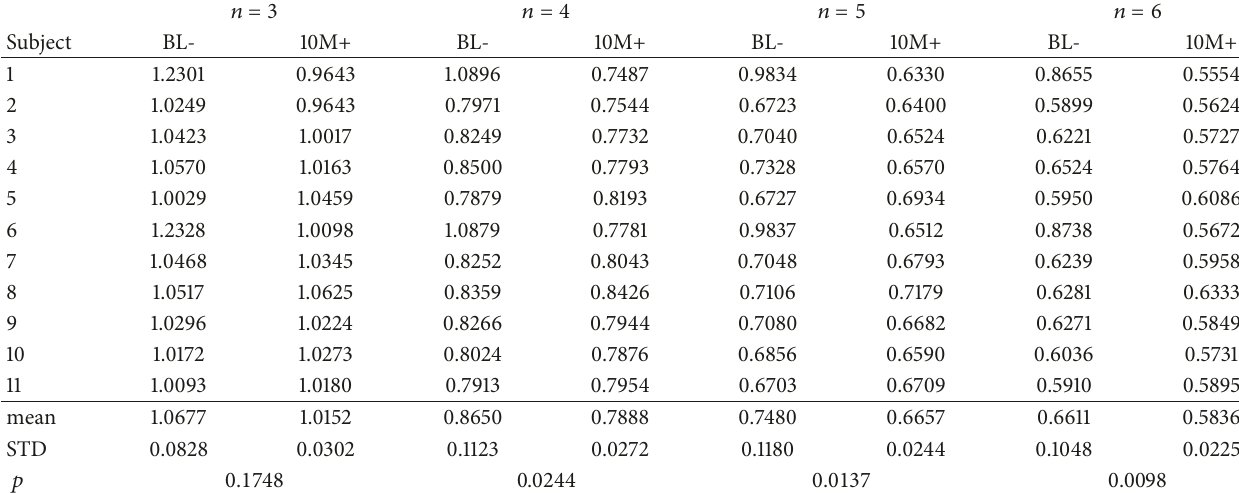
Table 7: Modified Permutation Entropy individual, mean, and standard deviation (STD) values of the two classes studied, BL- and 10M+ for 𝑛 = 3,4, 5, 6 . No significant differences between groups were found in some cases (Wilcoxon signed rank